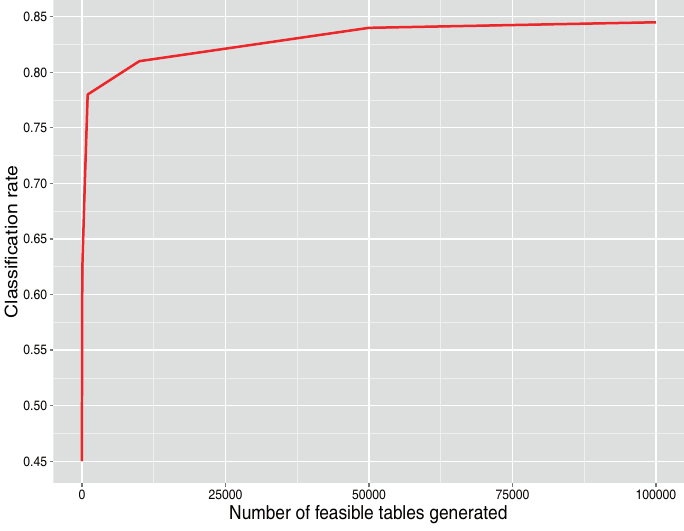
Figure 4. Classification rate as function of the number of feasible tables generated per